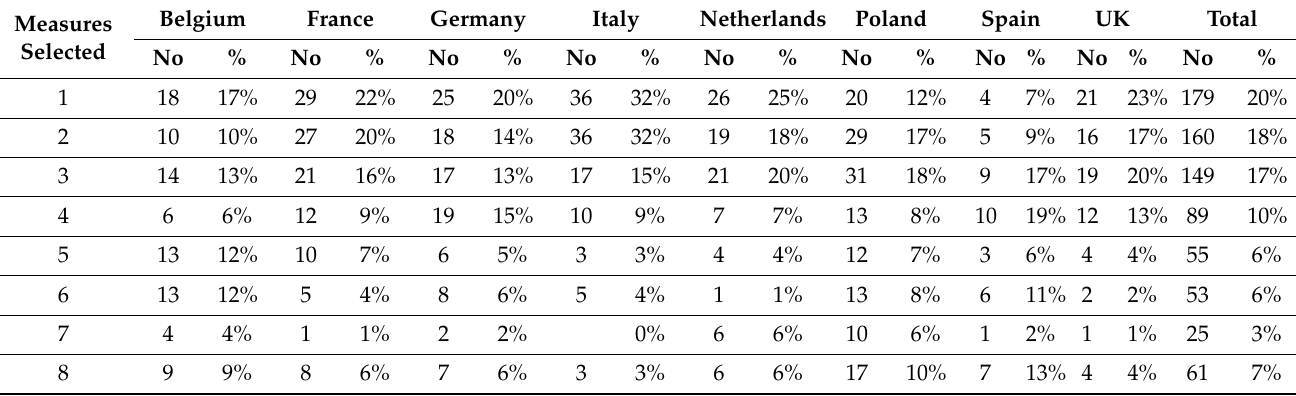
Table 5. Distribution of number of EERMs (out of 33)